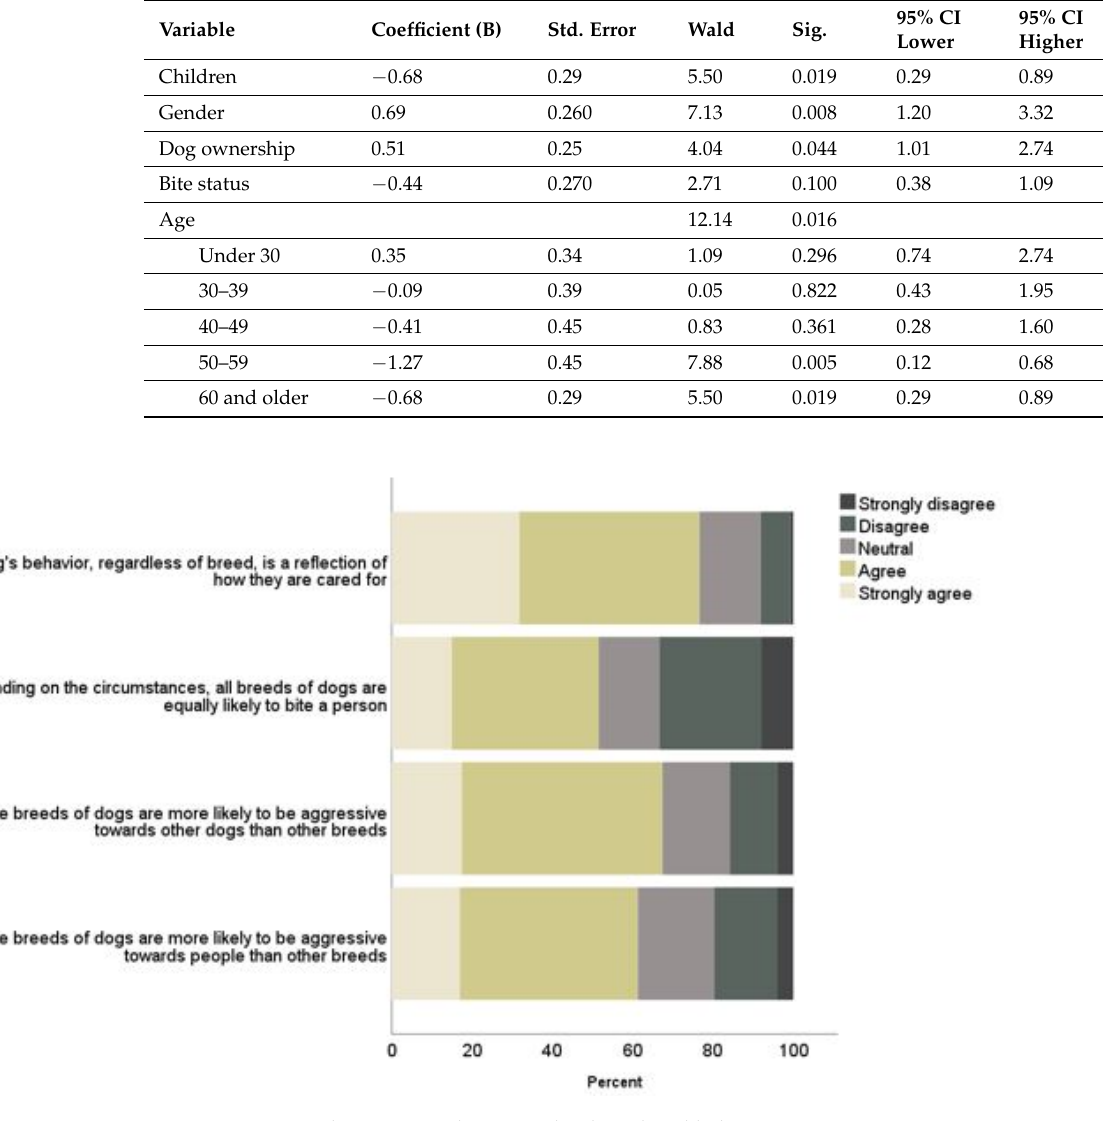
0.89 Half of participants agreed that banning specific breeds creates an animal welfare issue (56%), and 64% felt that banning certain breeds of dogs is an overreach of govern ‐ mental authority. Most also disagreed that particular dog breeds should not be allowed near children (71%) or that banning specific breeds of dogs improves public safety (82%).